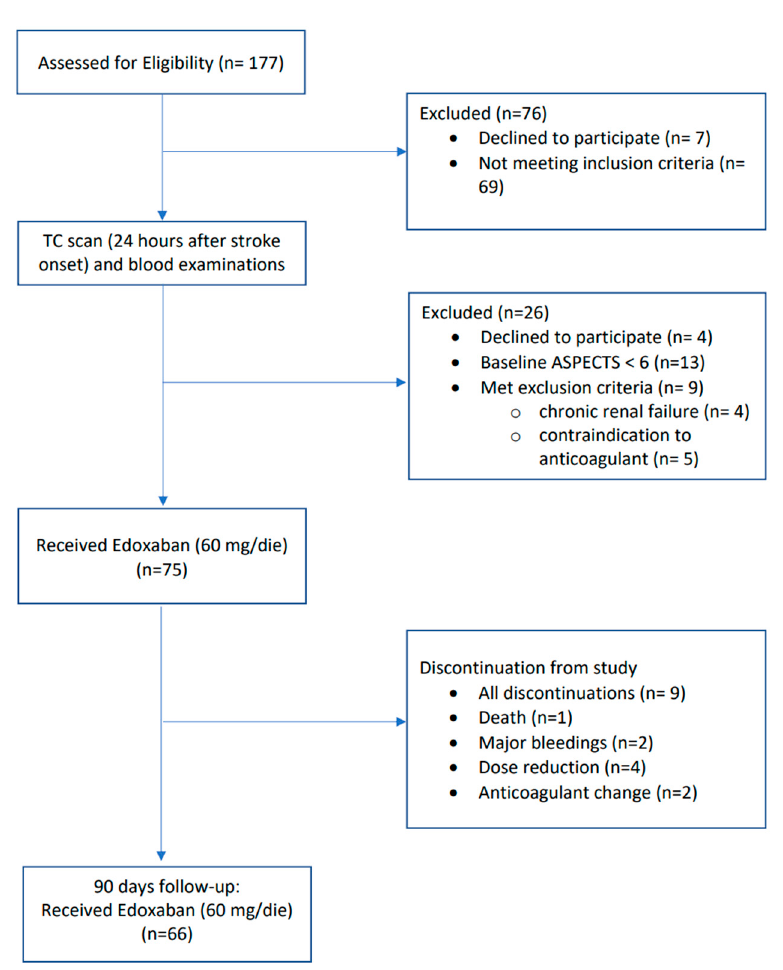
Figure 1. The CONsolidated Standards of Reporting Trials (CONSORT) flow diagram of the study showing data on enrolment, number of patients at different time points, withdrawal from the study, and mortality. Table 1. Demographic features, risk factors, stroke classification, clinical assessment, and proce- dures of patients included in the study.